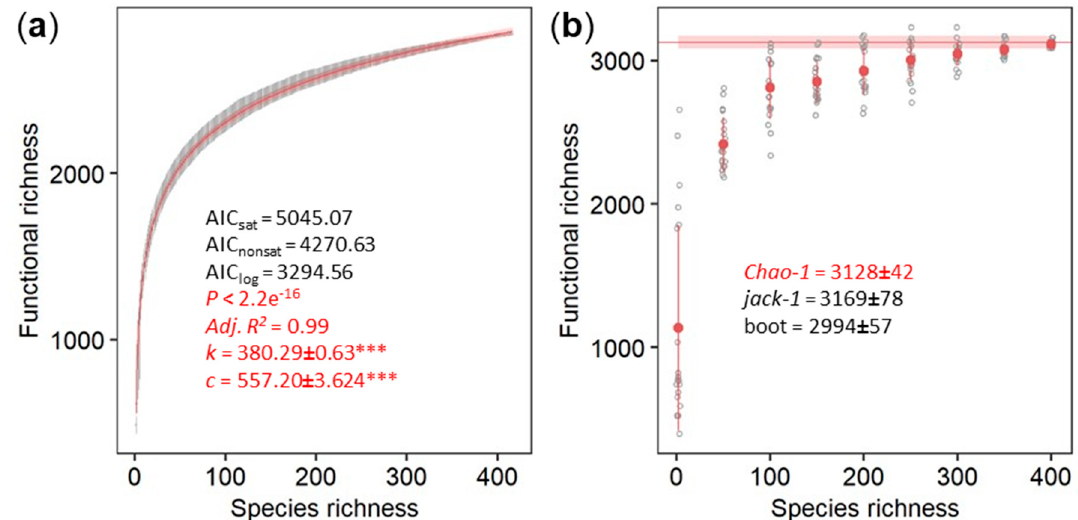
Figure 4. Parametric ( a ) and non-parametric ( b ) estimation of the total functional richness. The logarithmic model of the accumulation curves as gray points with error bars as 95% confidence intervals for the total known archaeal microbiome functions derived from the KEGG database by 1000 random permutations for every one species richness with 95% confidence intervals. Significance of the parameter estimates are indicated by asterisks (*** equals p < 0.001). The Chao-1 index as lower bound and non-parametric estimate was calculated using 20 replicates shown in gray for every 50 randomly picked archaeal genomes in the database starting with two species. The Chao-1 index of all 417 archaeal genomes with standard errors is shown as red